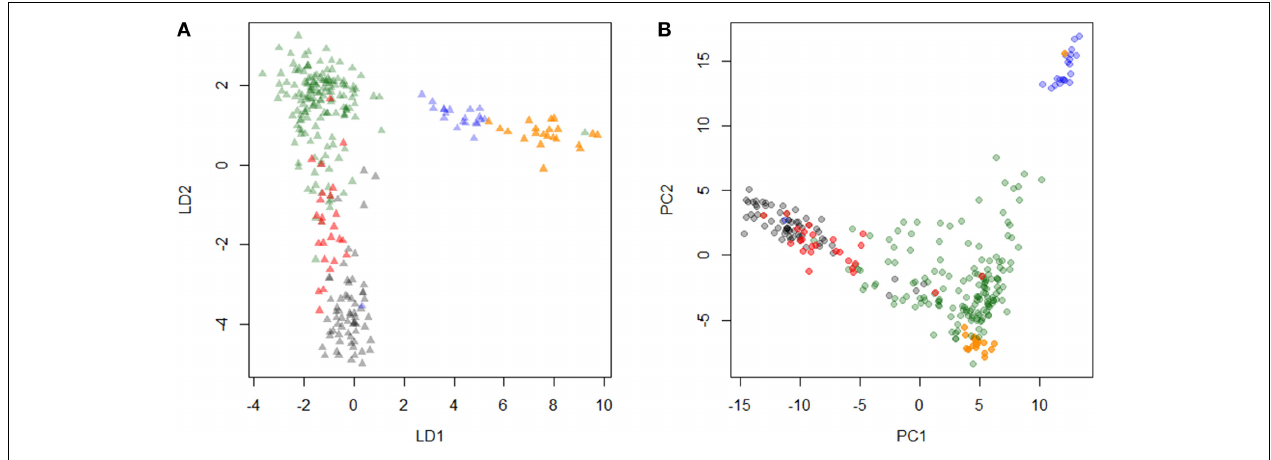
FIGURE 1 | Principal component analysis of Kenyan and other dairy cattle breeds. Discriminant analysis of principal component (DAPC) and principal component analysis (PCA) are plotted ( A,B ,